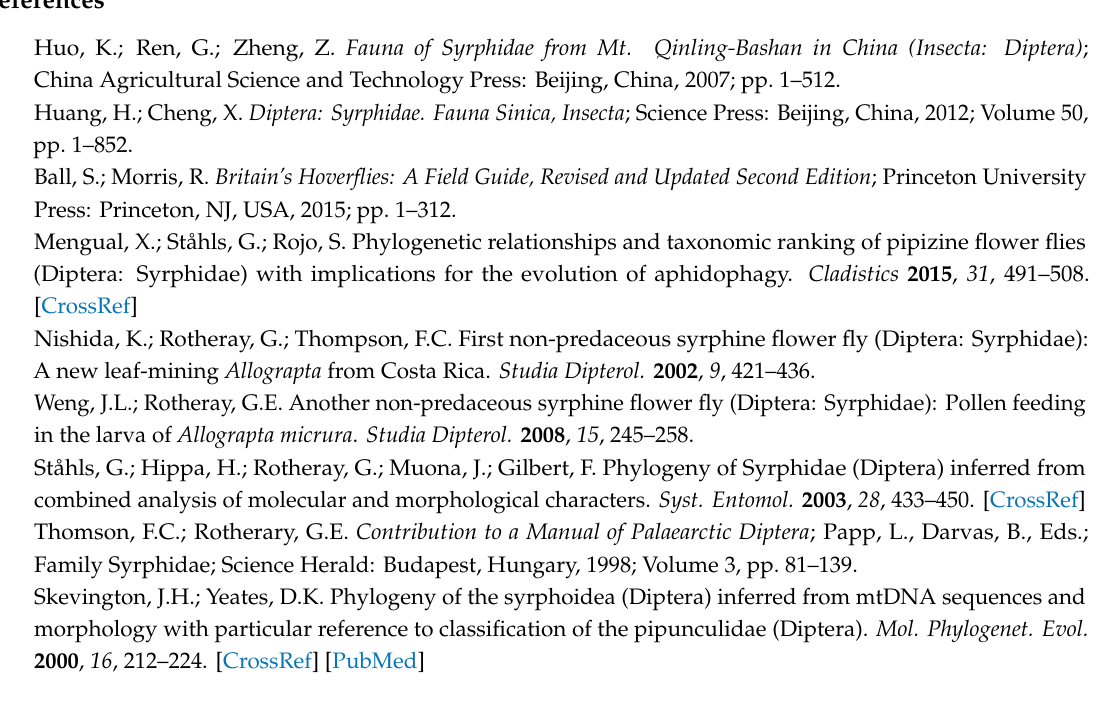
Figure S1: An agarose gel showing the bands of PCR fragments of COX1 (1–2) and 12s rRNA (3–4). M: Marker; 1, 3: Korinchia angustiabdomena ; 2, 4: Volucella nigricans , Table S1: Collection information of specimens in the present study, Table S2: List of mitochondrial genomes used for the phylogenetic analysis in this study, Table S3: Partition strategies and evolutionary models used in ML analysis, Table S4: Organization of the Korinchia angustiabdomena mitogenome, Table S5: Organization of the Volucella nigricans mitogenome, Table S6: Nucleotide compositions, AT- and GC-skew in rRNAs of sequenced Syphidae mitochondrial genomes. Author Contributions: H.L. conceived and designed the study, and wrote the entire manuscript. The author read and approved the final